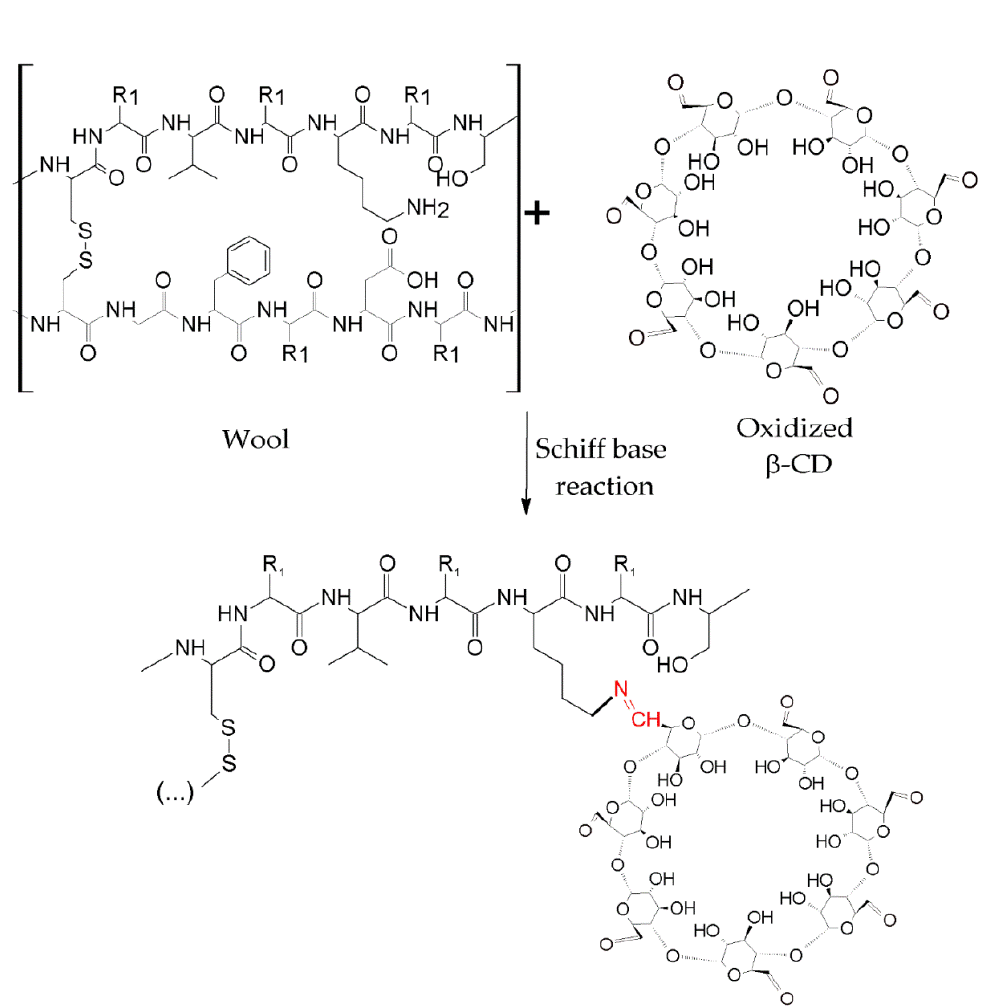
Figure 8. Functionalization of wool fibers with β-CD after oxidation .